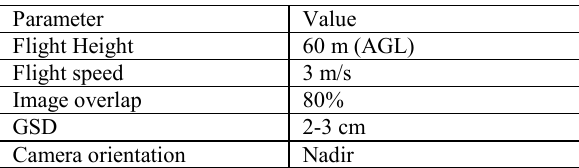
Table 2 UAV surveying